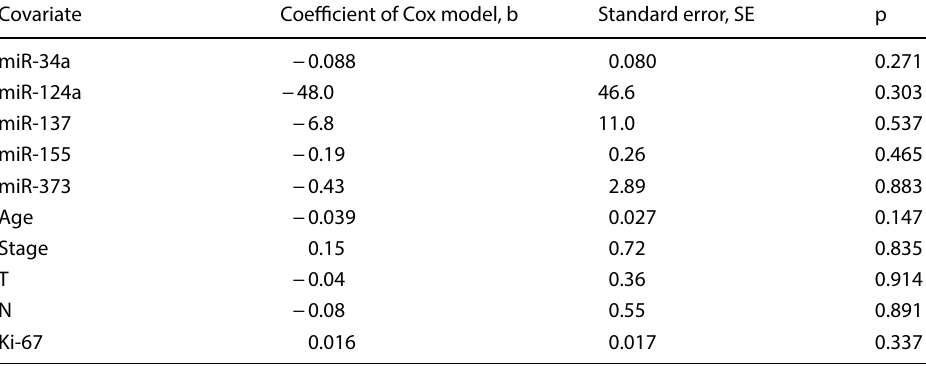
Table 2 Cox proportional analysis of the prognostic